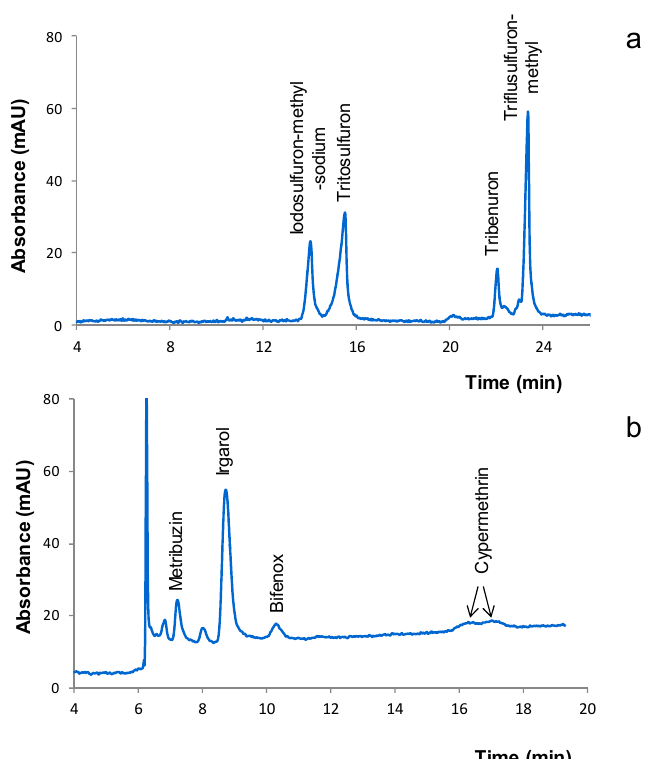
Figure 2. Chromatograms obtained under the proposed conditions for standard solutions of the analytes: ( a ) iodosulfuron-methyl-sodium, tritosulfuron, tribenuron-methyl and triflusulfuron-methyl (100 μ g/L each); ( b ) metribuzin, irgarol, bifenox and cypermethrin (25 μ g/L each). Table 4. Analytical parameters obtained with the silica nanoparticles (SiO 2 NPs) reinforced tetraethyl orthosilicate (TEOS)-trimethoxyethylsilane (MTEOS) capillary column.